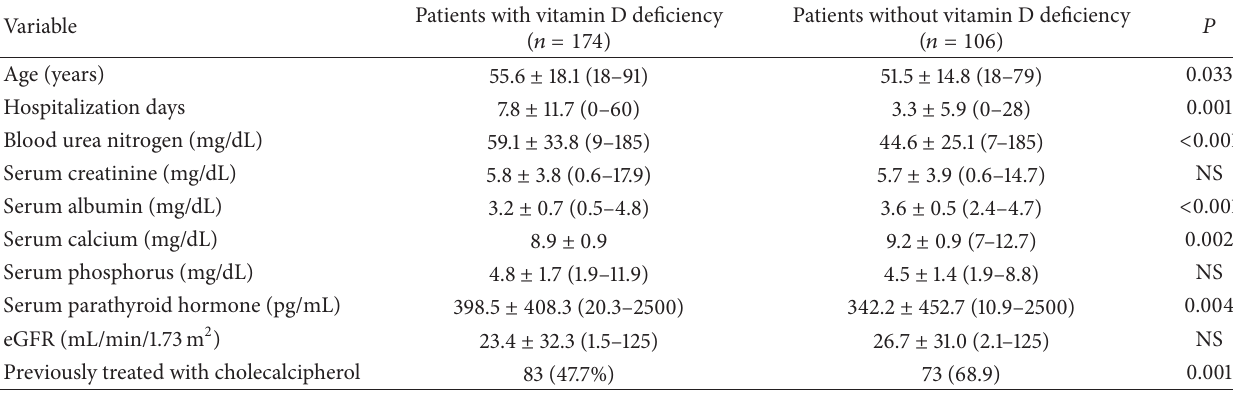
Table 3: Demographic and laboratory results of the patients with and without vitamin D